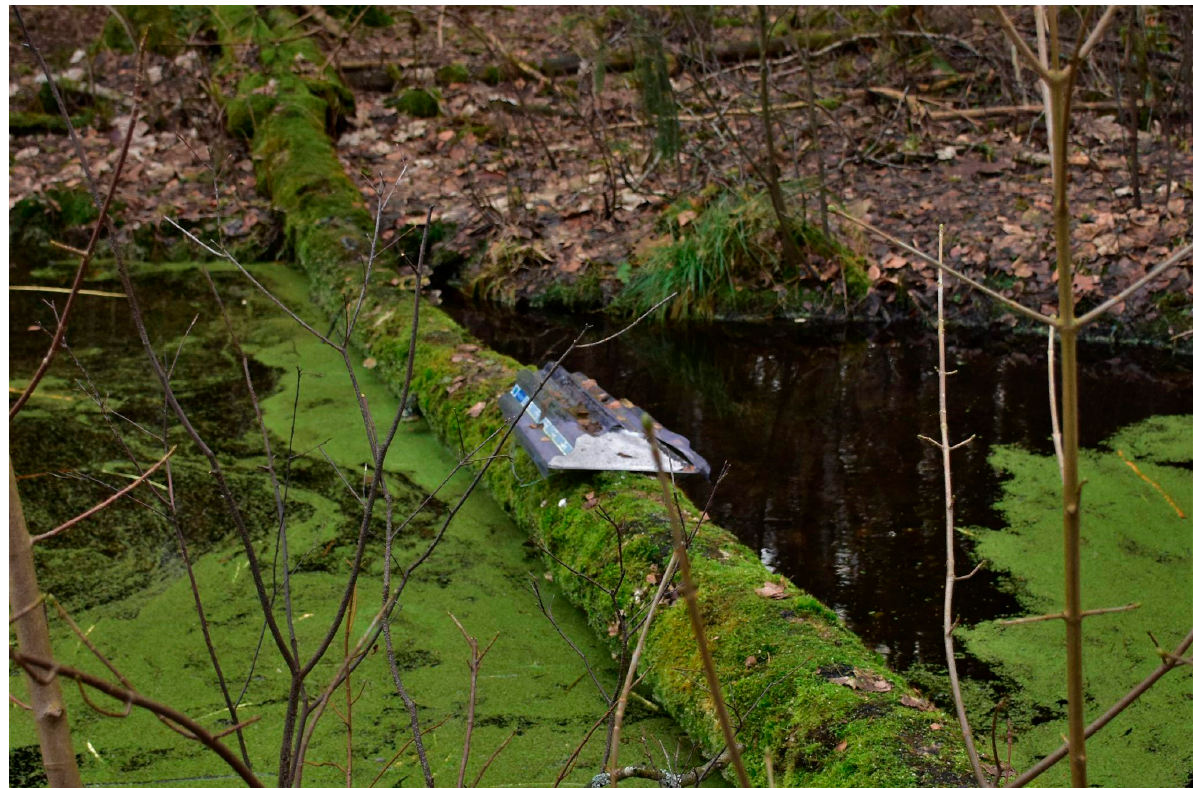
Figure 2. Tracking tunnel is fixed to the tree log that is connecting the banks of the stream (photo by Z. Wikar). Table 1. Research e ff ort and timing for the three sites. D—dam; L—log; R—raft. Site